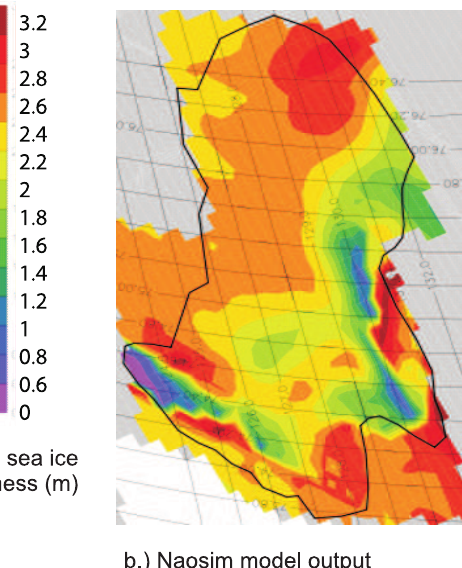
The Cryosphere, 7, 1107–1108, 2013